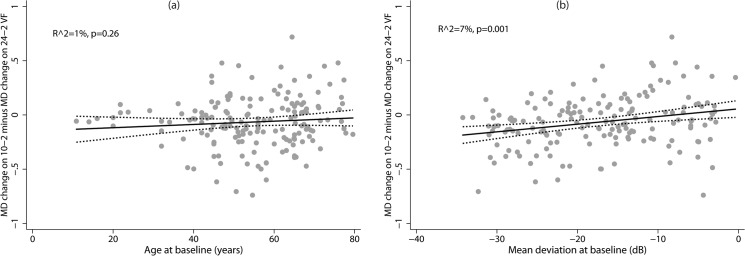
Influence of age and severity of glaucoma on the rate of mean deviation (MD) change on 10–2 and 24–2 visual fields.Difference in the rate of MD change between 10–2 and 24–2 fields and its relationship with (2a) age at baseline and (2b) severity of visual field loss (MD on 24–2 field) at baseline.